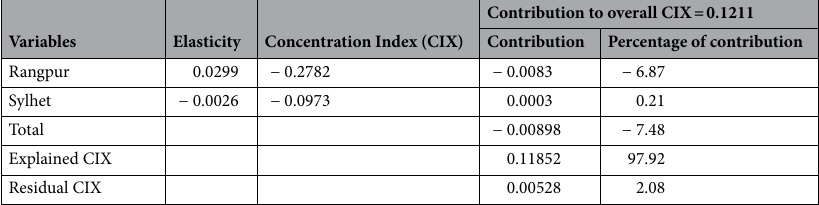
Table 2. Decomposition of the concentration index obtained with respect to wealth